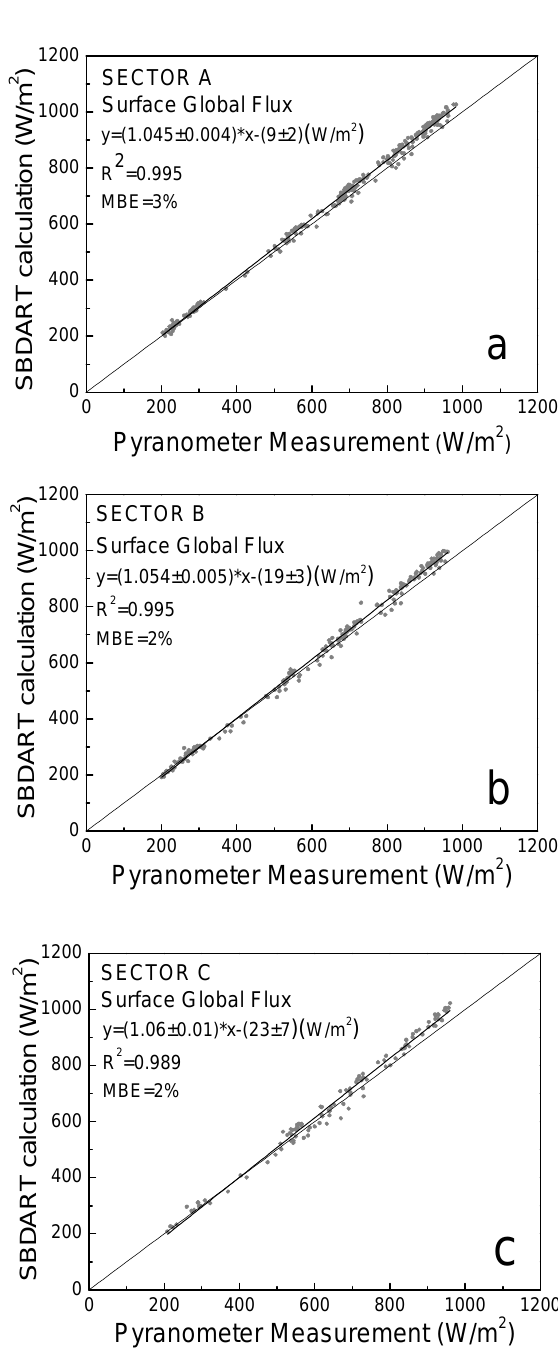
Fig. 4. Comparisons of surface global irradiance measurements ob- tained during desert dust events occurred at Granada during 2005– 2010 with SBDART modeled results for (a) Sector A, (b) Sector B and (c) Sector C. The regression equations, determination coeffi- cients and biases are included in these figures.